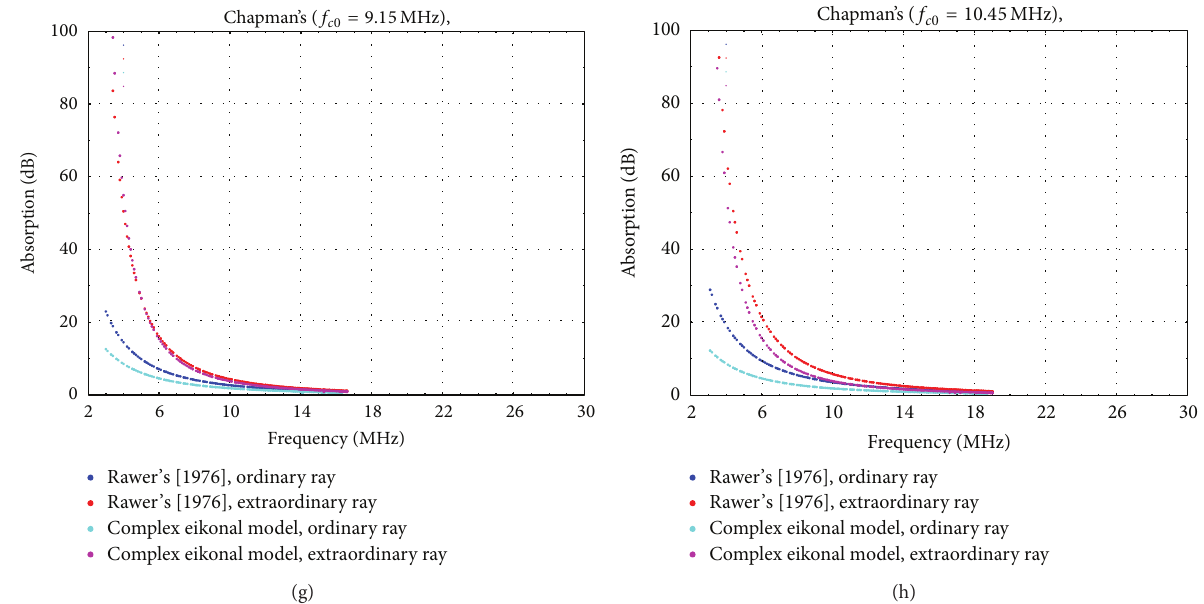
Figure 4: Plots of the percentage relative deviation [%], between the quasi-longitudinal (QL) approximation for nondeviative amplitude absorption according to the Settimi et al. [11] complex eikonal model (32), (33), and (34) and Rawer’s [12] theory (20a)-(20b), as a function of the frequency 𝑓 (MHz), for both the ordinary (a) and extraordinary (b) rays [The critical frequency at the Earth’s equator 𝑓 𝑐0 assumes the following values: 𝑓 𝑐0 = 3.65 MHz, 𝑓 𝑐0 = 5.65 MHz, 𝑓 𝑐0 = 6.85 MHz, 𝑓 𝑐0 = 7.60 MHz, 𝑓 𝑐0 = 7.80 MHz, 𝑓 𝑐0 = 8.60 MHz, 𝑓 𝑐0 = 9.15 MHz, = 10.45 𝑓 𝑐0